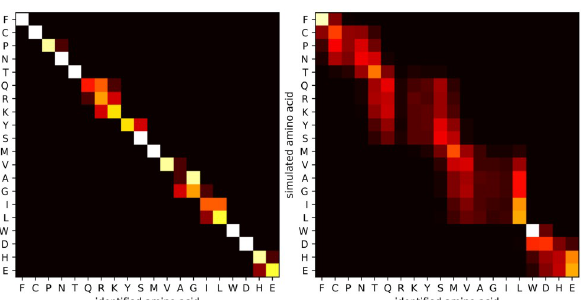
Fig 6. Heatmaps for isolated amino acid identification for measurement times per amino acid of 1000 ms and 10 ms. A heatmap for measurement time of 100 ms is shown in Fig 4. (left) With a measurement time of 1000 ms, the average identification accuracy is 79.50%. With 11 clusters (PN, QRK, YS, VAGIL, HE, and 6 singletons) the cluster identification accuracy is > 95%. (right) With a measurement time of 10 ms, the average identification accuracy is 32.94%. With 3 clusters (FCPNT, QRKYSMVAGIL, and WDHE), the cluster identification accuracy is > 95%. Sequencing simulations were done for the carboxyl terminal group, at pH 3.0, and an SNR of 10.